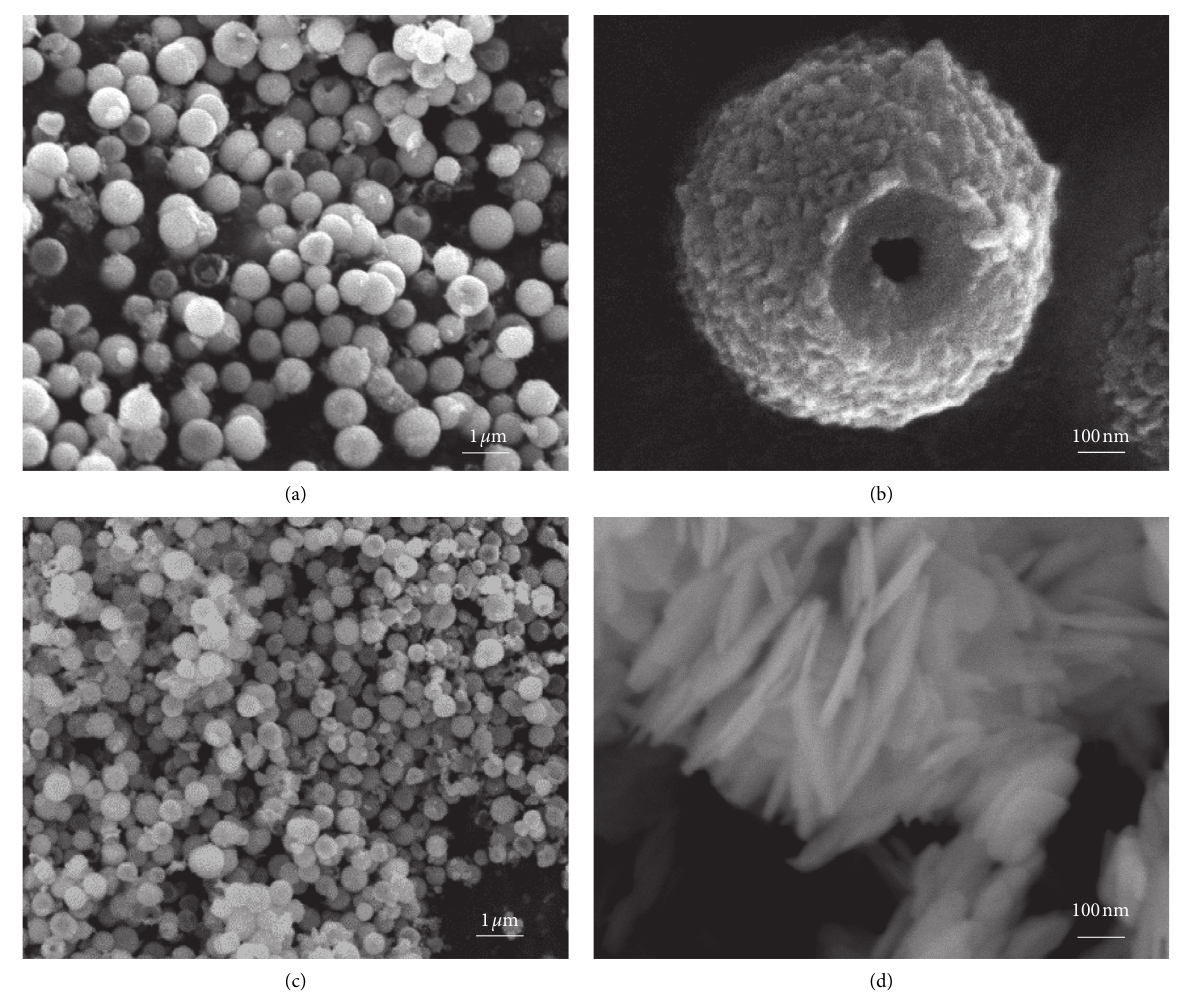
Figure 3: FESEM images of the (a, b) HBSMs, (c) BiOBr-GC, and (d) BiOBr-IP.